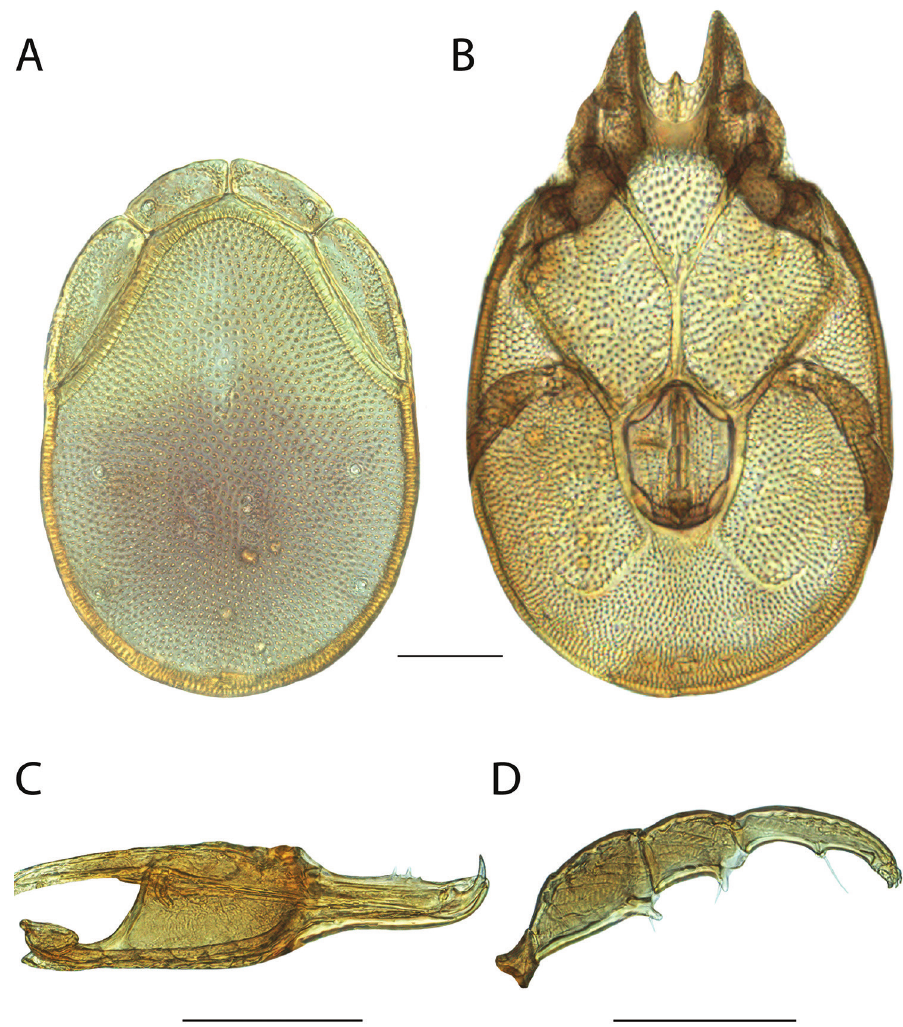
Figure 55. Torrenticola dentirostra sp. n. male: A dorsal plates B venter (legs removed) C subcapitulum D pedipalp (setae not accurately depicted). Scale = 100